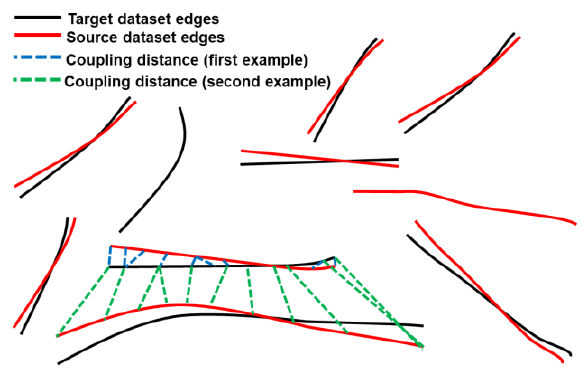
Figure 2. Example showing edge matching and DFD.